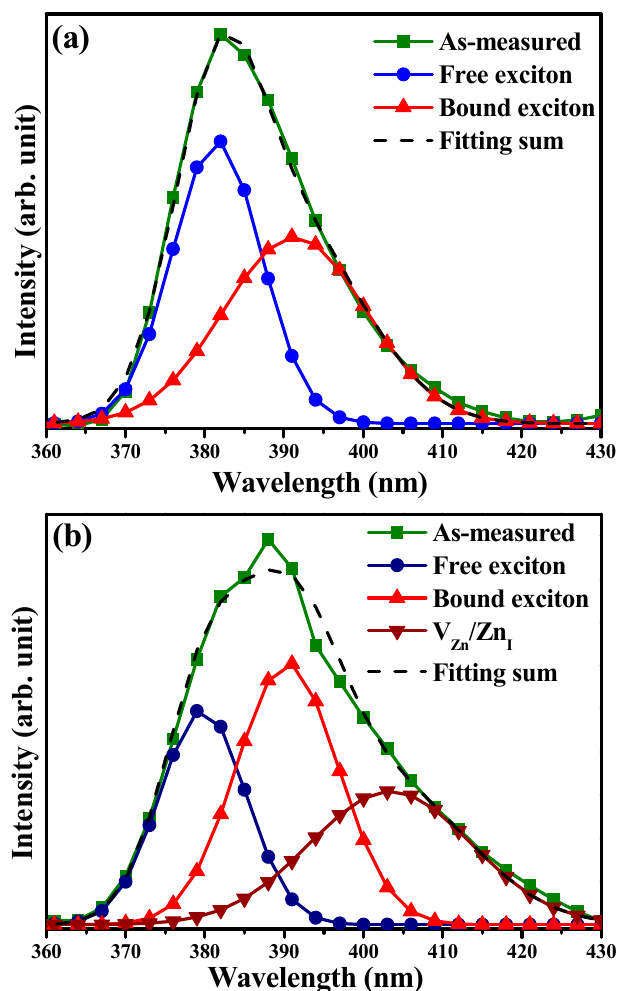
Figure 8. A deconvolution on this UV light luminescence that emerged from the ( a ) single ZnO film and ( b ) AlN-ZnO/ZnO structure, respectively.